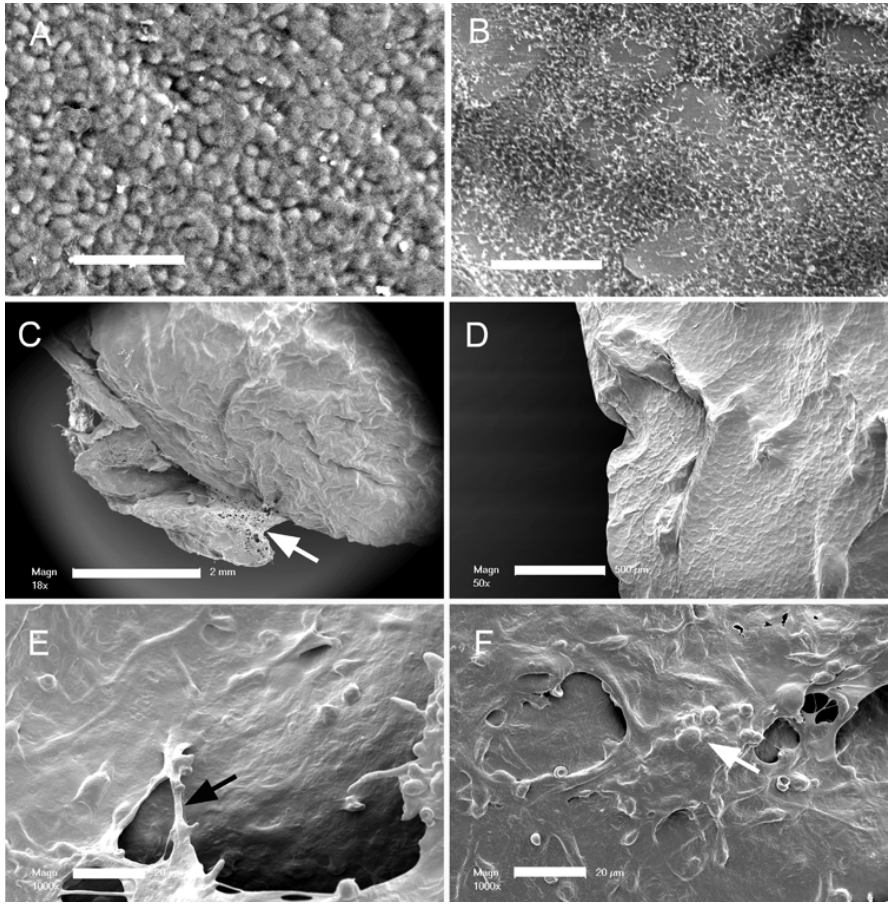
Figure 1. Scanning electron microscopy of the murine visceral pleural surface before and after the application of the pectin bioadhesive. ( A ) Normal visceral pleural surface with cobblestone mesothelial cells (bar = 50 um). ( B ) The dense microvilli on the mesothelial cell surface is visible with higher magnification (bar = 20 um). ( C , D ) After application of the pectin film, there is a notable change in the surface morphology, with the microvilli apparently covered by the pectin film. Note the pectin adapting to the contour of the pleural surface ( C , bar = 2 mm; D , bar = 500 um). The unbound pectin developed a cribiform pattern (arrow), suggesting dissolution of the unbound pectin ( E , F ). Higher magnification of the pectin film showed evidence of fibrillation or stranding between the bound pectin film and unbound films (white arrow), as well as molding around mesothelial cell nuclei (black arrow) ( E , D bar = 20 um).